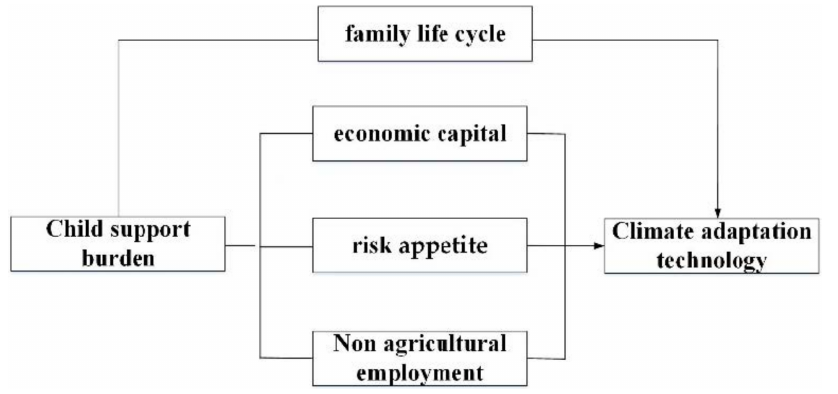
Figure 1. Technical route framework